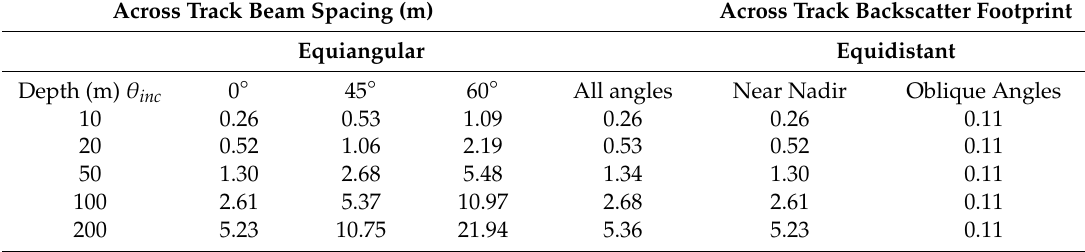
Table 2. Across-track beam spacing and backscatter sample footprint for various depths and transmission angle for MBES with a beamwidth of 1.5 ◦ and pulse length of 150 µ s assuming a sound speed of 1500 ms − 1 . The across-track backscatter footprint depends on the depth in near nadir region, but only depends on the pulse length at oblique angles.